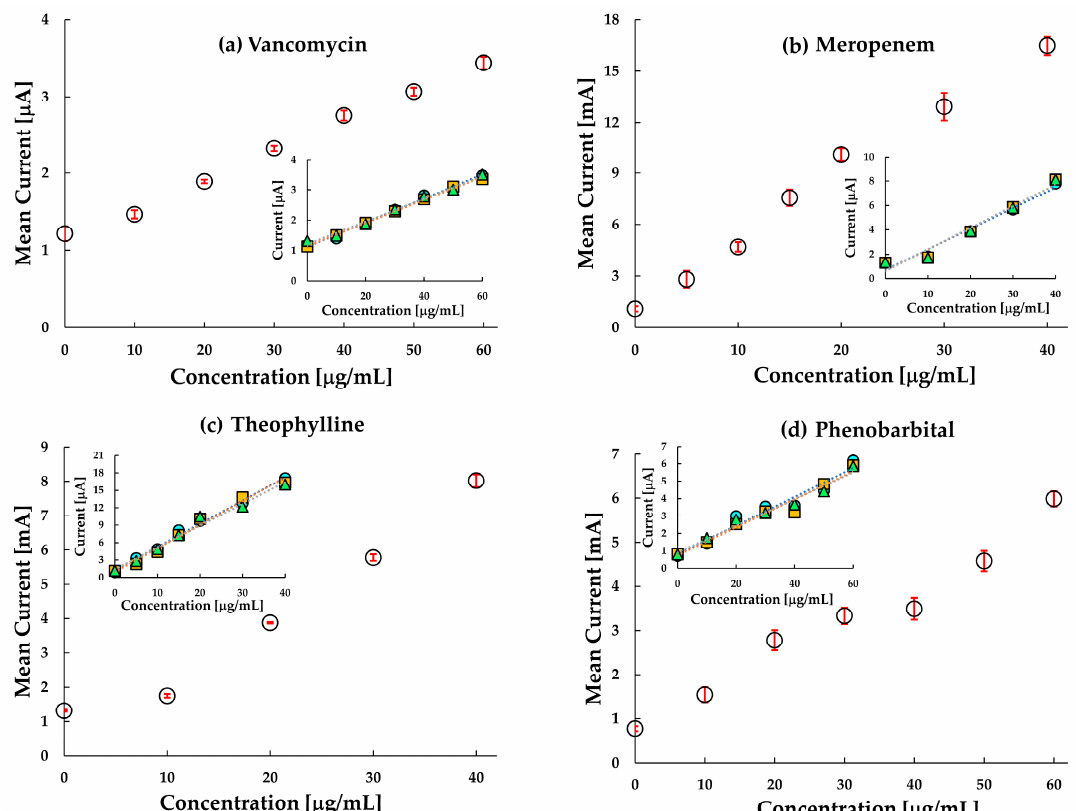
Figure 5. Reproducibility test in saline of the target by MIP for: ( a ) vancomycin, ( b ) meropenem, ( c ) theophylline and ( d ) phenobarbital. The mean current value for three sensors at each concentration is plotted with standard deviation at each value as the error. The response at every concentration for three different chips for every drug is shown in the inset.